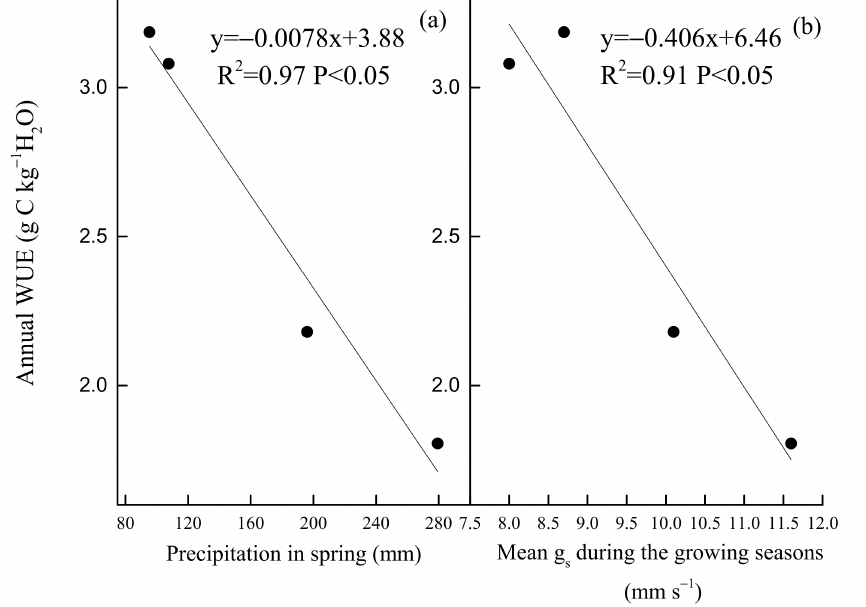
Figure 13. Relationships between annual WUE and ( a ) mean soil water content (SWC) in spring (April–May) and ( b ) mean midday surface conductance (g s ) during the growing seasons of 2017 to 2020.